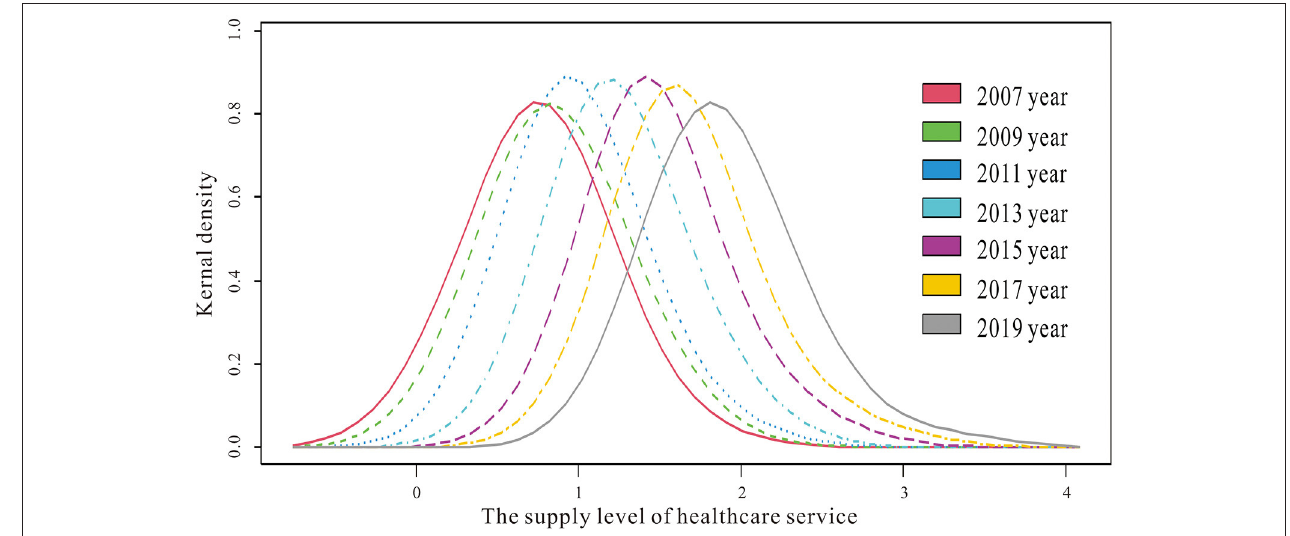
FIGURE 1 | Kernel density estimation of the supply level of healthcare